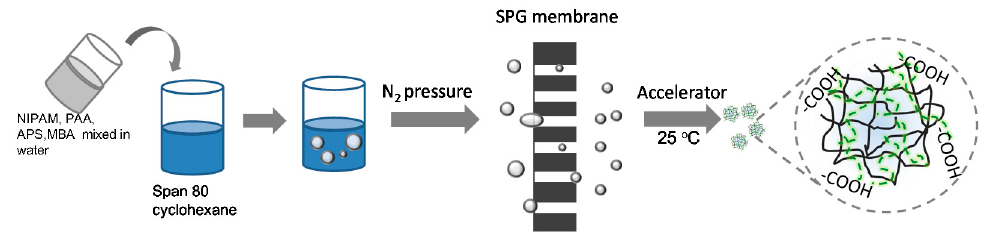
Figure 1. Process for the preparation of PNIPAM/PAAc semi-IPN microspheres. Table 1. Recipes for the preparation of PNIPAM-based microspheres.